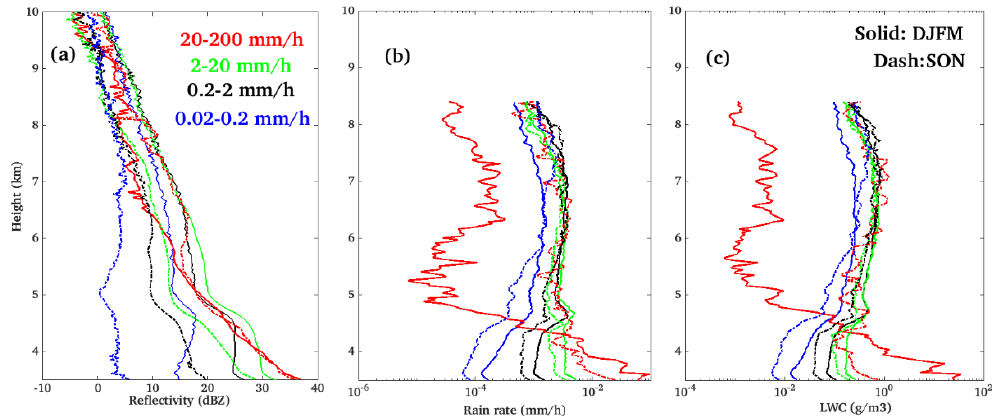
Figure 6. Average vertical profile for different class of near surface rain rate for ( a ) radar reflectivity (in dBZ), ( b ) rain rate (mm/h) and ( c ) liquid water content (g m − 3 ) for three study periods mentioned in the text.